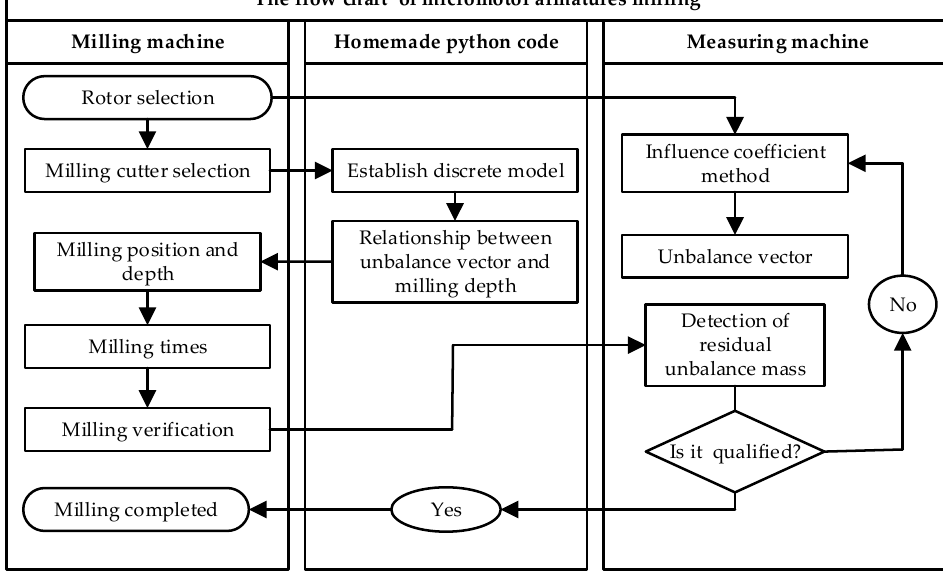
Figure 12. The flow chart of micromotor armatures milling.